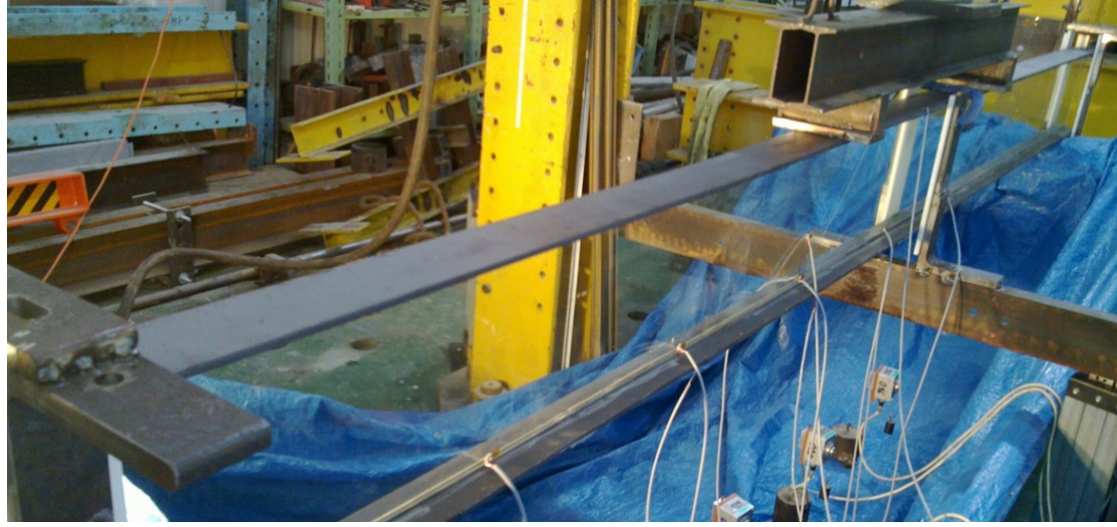
Fig. 10 Hybrid steel-glass